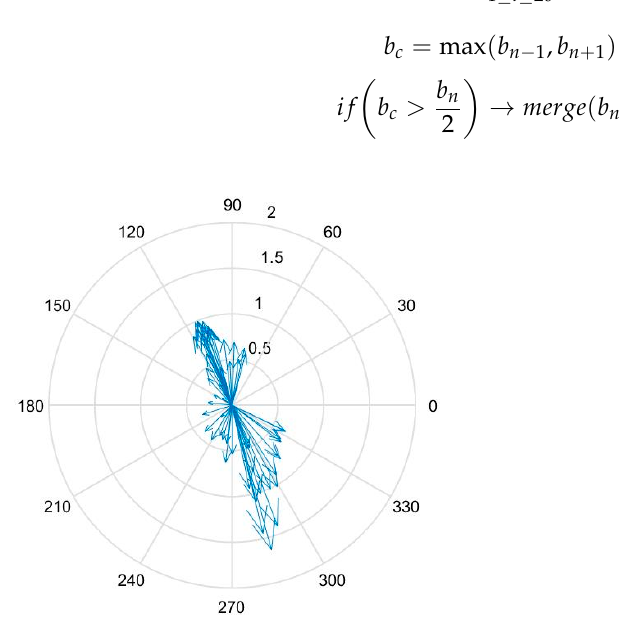
Figure 13. Accelerations in polar axes “compass”.